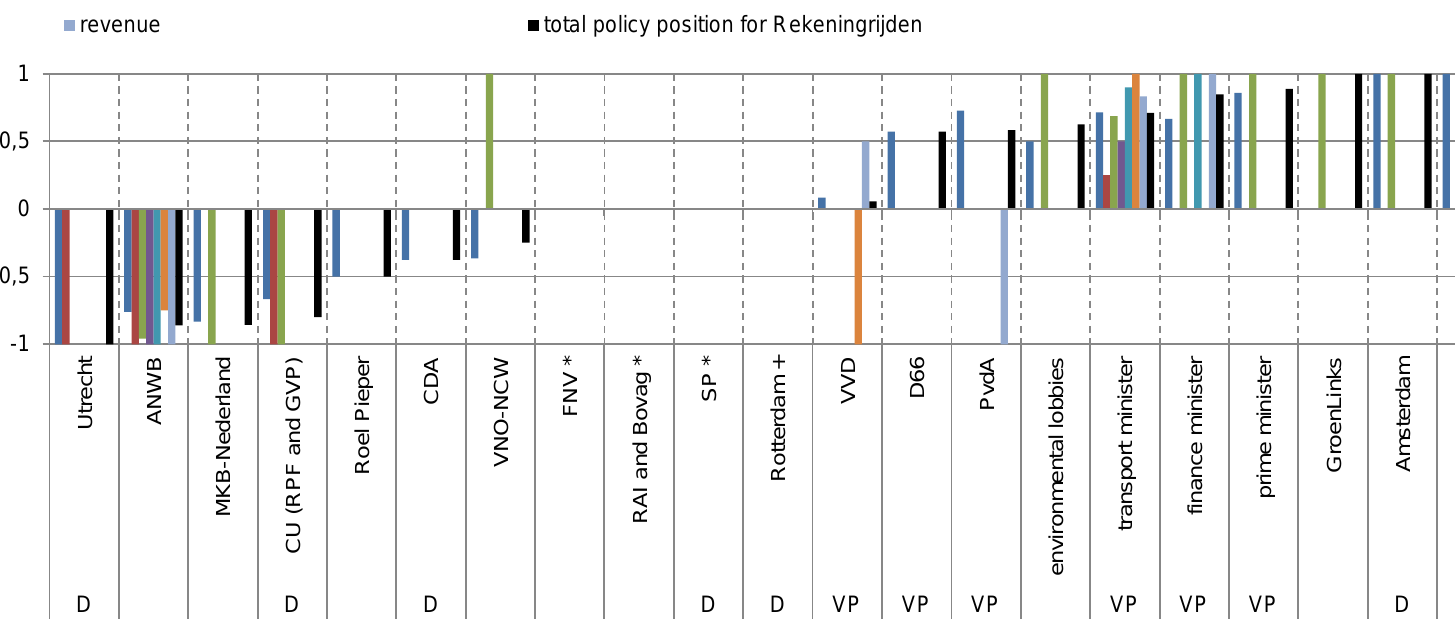
Figure 2. Pro- and anti- Rekeningrijden advocacy coalitions in government period 2 – before the Mobimiles report (1998 –